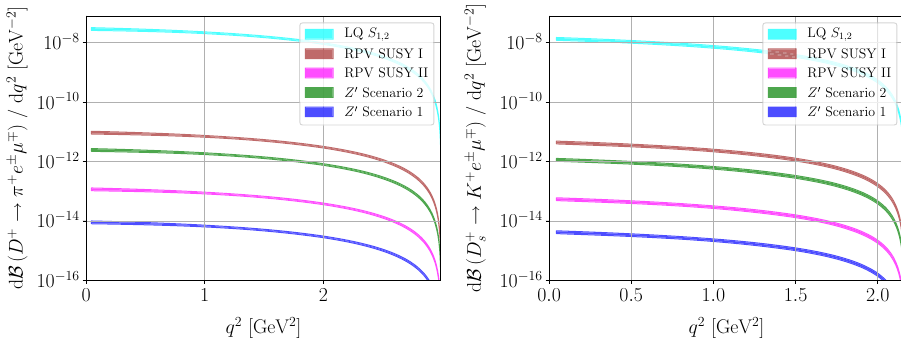
= − ( K + K (cid:3) ) = 4 . 6 × 10 − 3 (green), and solution 1, K 9 + K (cid:3) 10 9 10 = − ( K + K (cid:3) ) = 2 . 8 × 10 − 4 (blue). Solutions 3-6 , 8 (not shown) give rates near the magenta RPV SUSY II band. See text for details